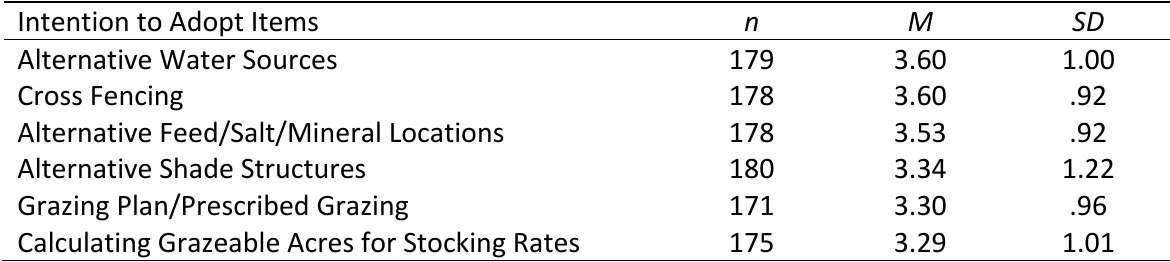
Descriptive Statistics for Intention to Adopt Intention to Adopt Items